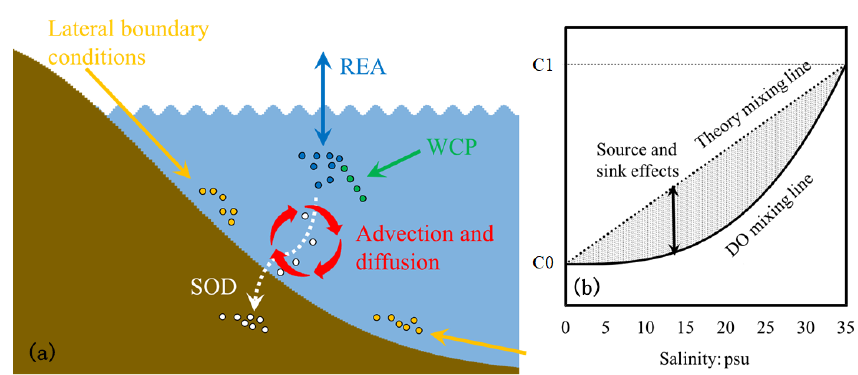
Figure 3. (a) Schematic diagram illustrating the mixing process of dissolved oxygen in the estuary and (b) schematic plot for dissolved oxygen versus salinity (the solid black curve line) during mixing in the estuary. C 1 represents the concentrations in seawater, while C 0 represents the concentrations in river